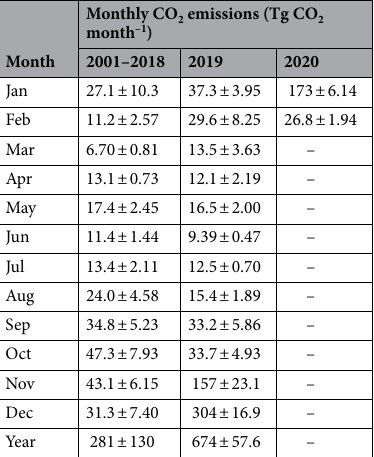
Table 1. Average and one standard deviation of monthly CO 2 emissions (Tg CO 2 month −1 ) between 2001– 2018 and 2019–2020 in Australia. Note that the average and one standard deviation for 2001–2018 were measured for each month of the year, and those of 2019 and 2020 indicate the eight results from a combination of input sources.